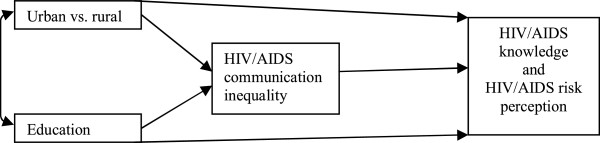
Hypothesized model.